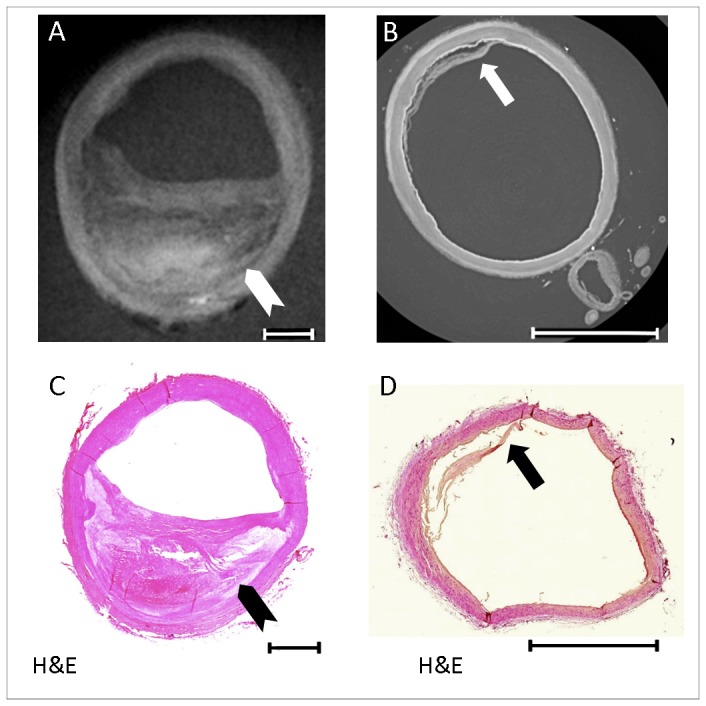
Comparison of PC-CT images recorded at synchrotron and laboratory sources.(A) Axial reconstructed PCI slice from the conventional X-ray tube of the common carotid artery with a large atherosclerotic plaque. The chevron points to a large lipid-rich necrotic core covered by a fibrous cap;.(B) Axial reconstructed PCI slice from the synchrotron facility of the distal external carotid artery with moderate intimal thickening; the arrow points at a detachment of the intimal layer.(C) and (D) corresponding histology sections (PCI = Phase Contrast Imaging; Length of the scale bar = 2 mm).